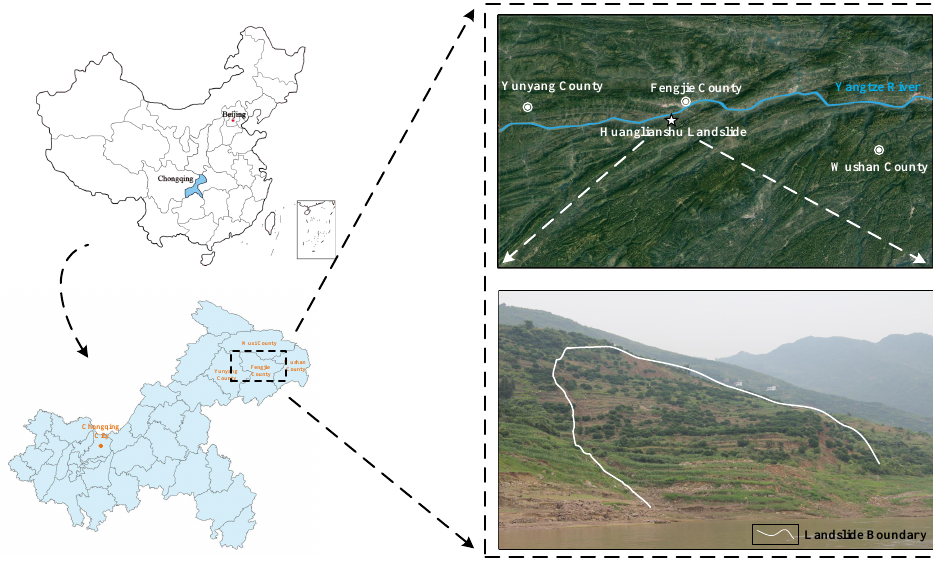
Figure 1. Geographical location of the Huanglianshu landslide.